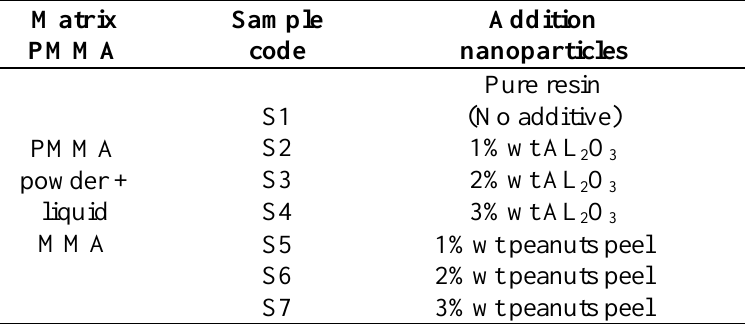
Table 1: Symbols of each type of material under